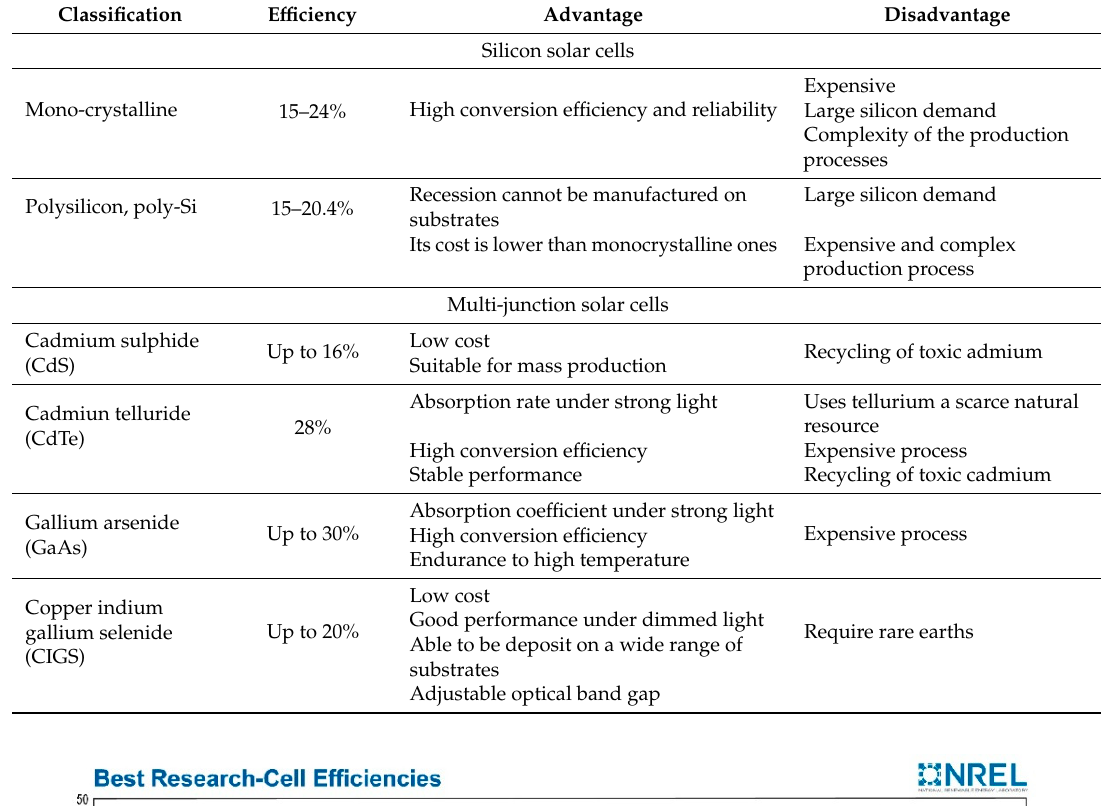
Table 2. Comparison of various solar cells types.